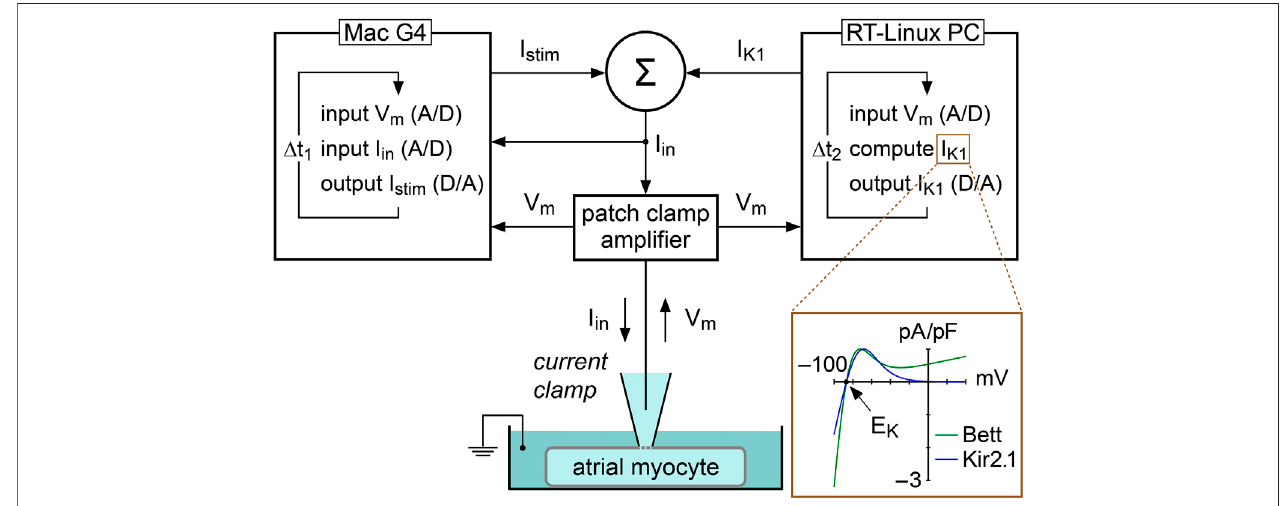
FIGURE 1 | Experimental approach to supply a patched atrial myocyte with a synthetic inward recti fi er K + current (I K1 ). A Real-Time Linux (RT-Linux) based PC computesthesyntheticI K1 accordingtothemembranepotential(V m )thatisreadintothePC.Afteradditionofanystimuluscurrent(I stim ),thisI K1 issenttothepatchclamp ampli fi er, which operates in current clamp mode and injects the net current (I in ) into the patched myocyte. This process is updated with a time step Δ t 2 of 40 µs. I stim is sentoutbytheAppleMacintosh(Mac)G4computerthatisusedtocontroltheexperimentandrecordbothV m andI in atarateof40 kHz,correspondingwithatime step Δ t 1 of 25 µs. Inset: current – voltage relationship of the synthetic I K1 with moderate recti fi cation ( “ Bett ” current; Bett et al., 2013) and the synthetic I K1 with strong recti fi cation ( “ Kir2.1 ” current; Meijer van Putten et al., 2015). E K denotes the potassium equilibrium potential.